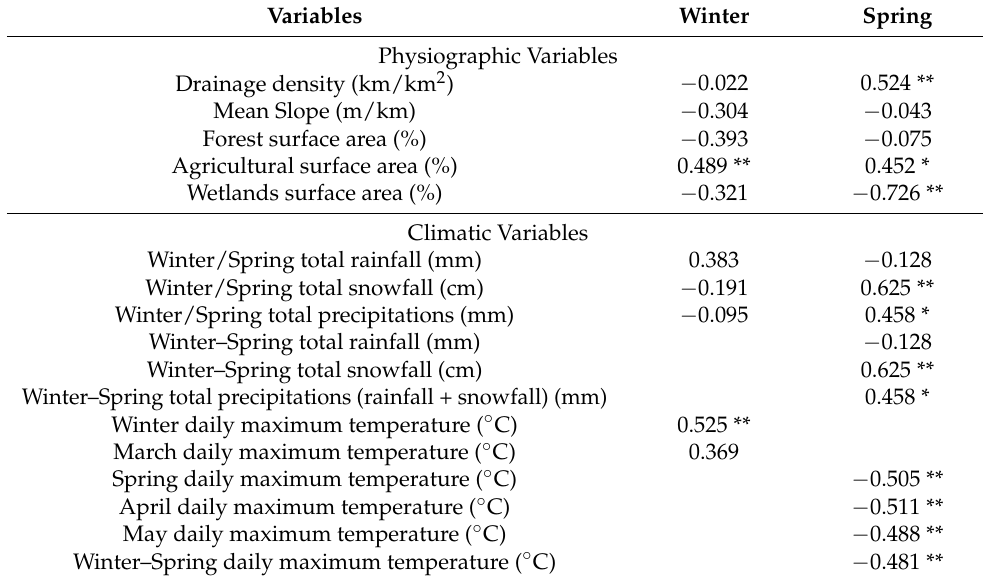
Table 2. Correlation coefficients calculated between physiographic variables and magnitude (L/s/km 2 ) of winter and spring maximum daily flows from